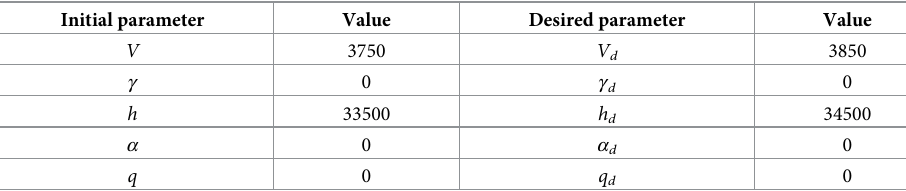
Table 1. Initial and desired data.